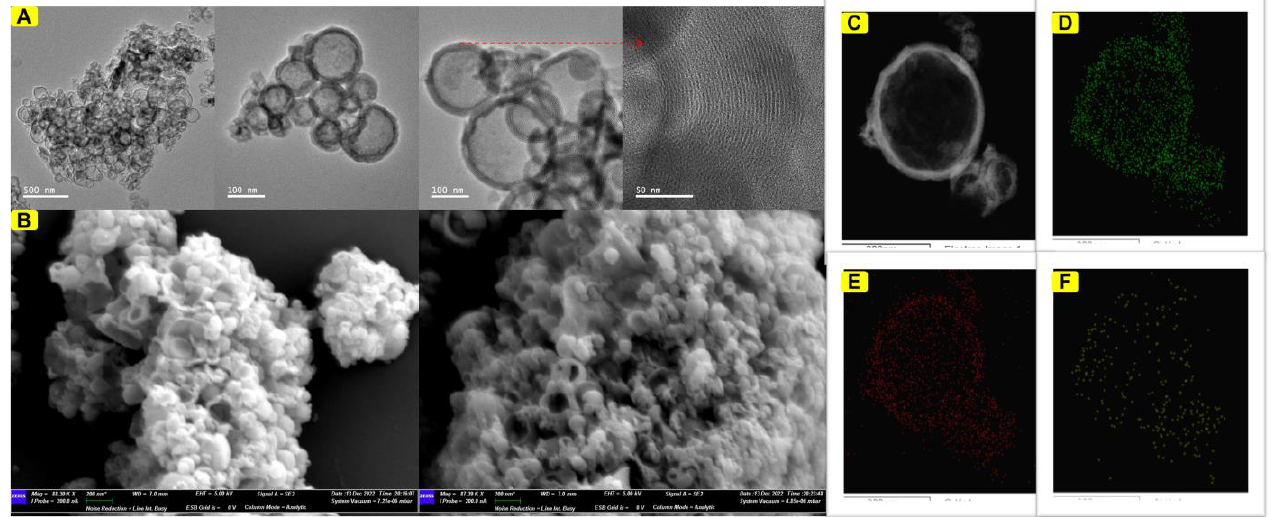
Figure 3. ( A ) UHR-TEM images of PHMS − 2. ( B ) FE-SEM micrographs of PHMS−2 . ( C ) Elemental analysis specimen. ( D ) Elemental mapping for Si. ( E ) Elemental mapping for O. ( F ) Elemental mapping for Al .